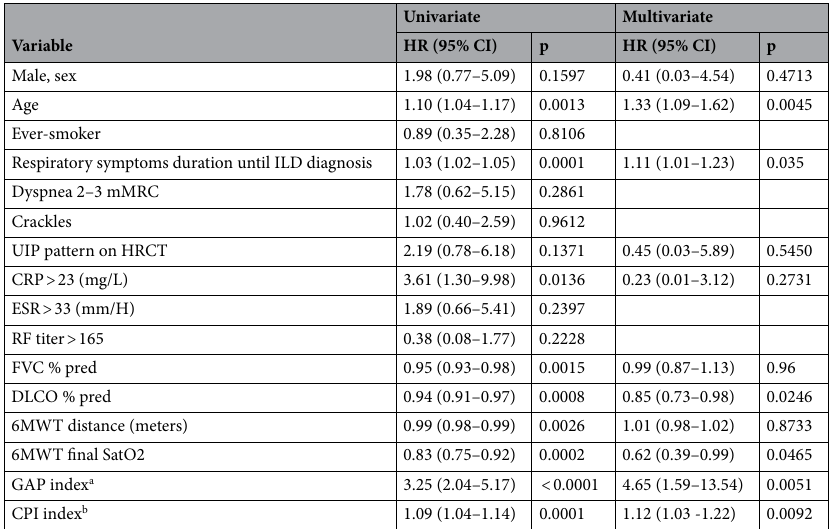
Table 3. Univariate and multivariate analysis of mortality predictors. mMRC: modified Medical Research Council; UIP: usual interstitial pneumonia; HRCT: high-resolution computed tomography; CRP: C-reactive protein; ESR: erythrocyte sedimentation rate ; RF: rheumatoid factor; FVC: forced vital capacity; DLCO: diffusion capacity for carbon monoxide; 6MWT: six minutes walking test; GAP: gender [G], age [A], and lung physiology variables [P] index; CPI: composite physiologic index. a Adjusted by ESR > 33 mm/H, CRP > 23 mg/L, radiological pattern on HRCT, respiratory symptoms duration until ILD diagnosis, and final oxygen saturation in the 6MWT. b Adjusted by ESR > 33 mm/H, CRP > 23 mg/L, radiological pattern on HRCT, respiratory symptoms duration until ILD diagnosis, final oxygen saturation in the 6MWT and age.